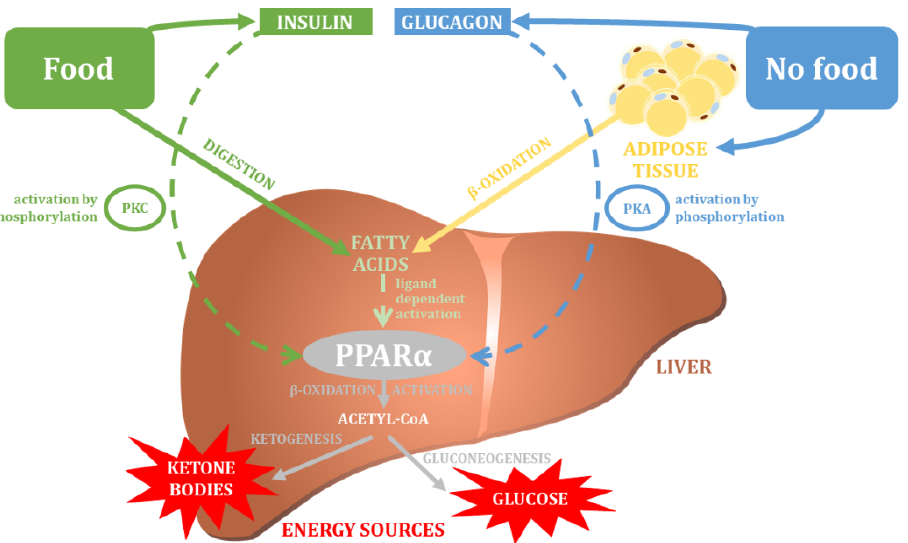
Figure 4. The main physiological function of PPAR α (own elaboration, after: Pawlak et al. 2015 [150]). PKC—protein kinase C; PKA—protein kinase A.